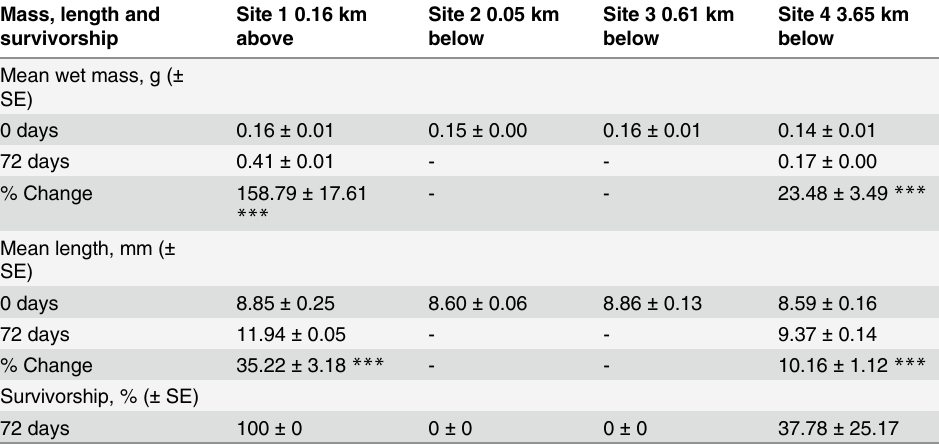
Post-exposure data for Sites 2 and 3 are unavailable due to complete mortality of C . fl uminea at those sites. Signi fi cant results of t-tests comparing pre- and post-exposure data within sites indicated by asterisks: *** Indicates p-value of <